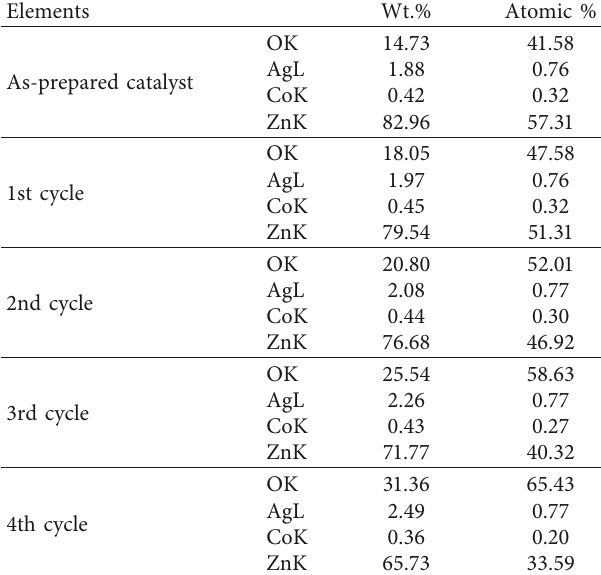
° C; 2 O 2 /styrene, 2.5, temperature, 80 Table 4: EDX analysis of C4 before using and at the 1st, 2nd, 3rd, and 4th cycles. Elements Wt.% Atomic